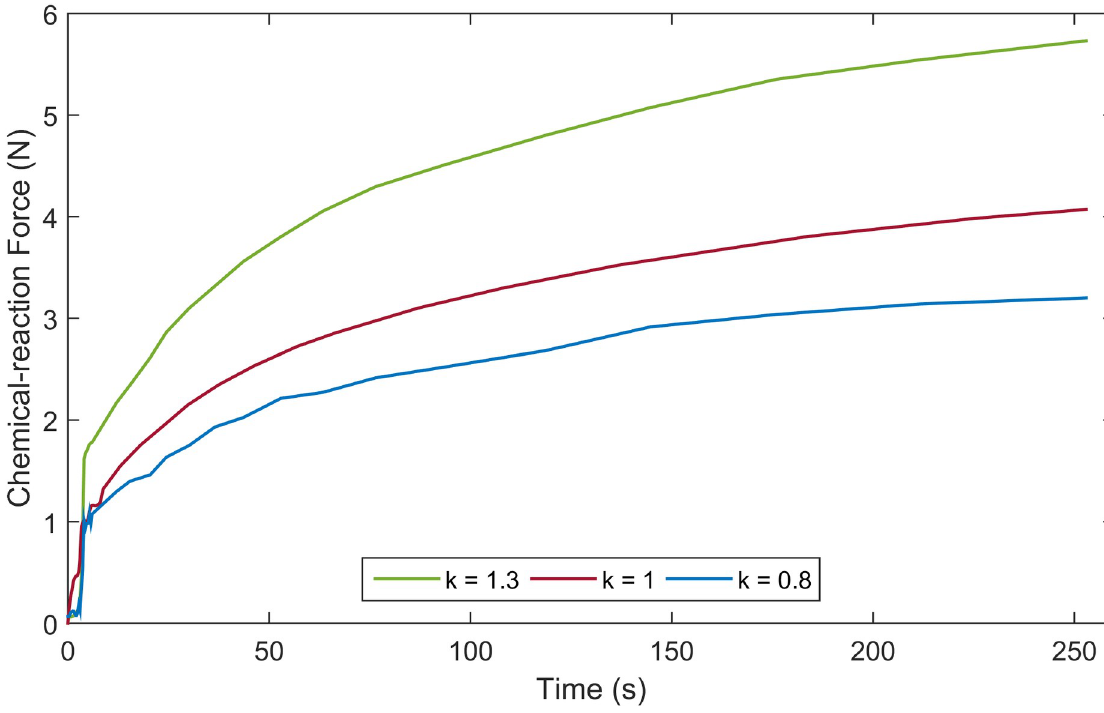
Fig 11. Experimental results of the chemical reaction force for various amounts of reactants.